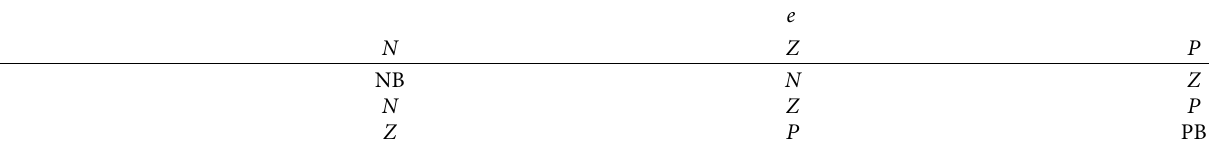
Table 1: Fuzzy rule base.